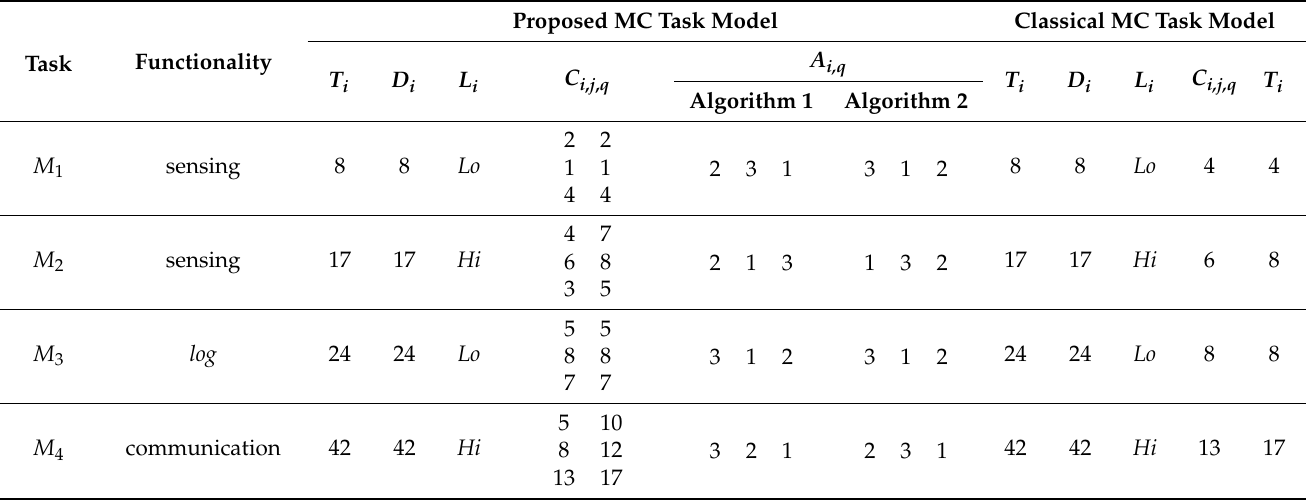
Table 2. Task Model Example 1.